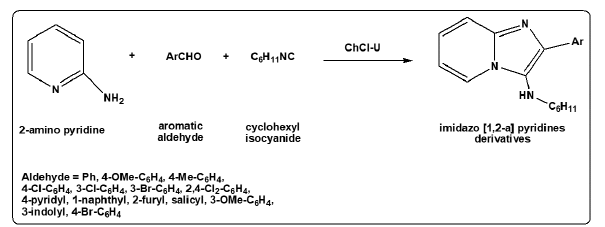
Figure 19: Three component reactions of 1,3-dicarbonyl compounds, aldehydes and malononitrile in DESs. n